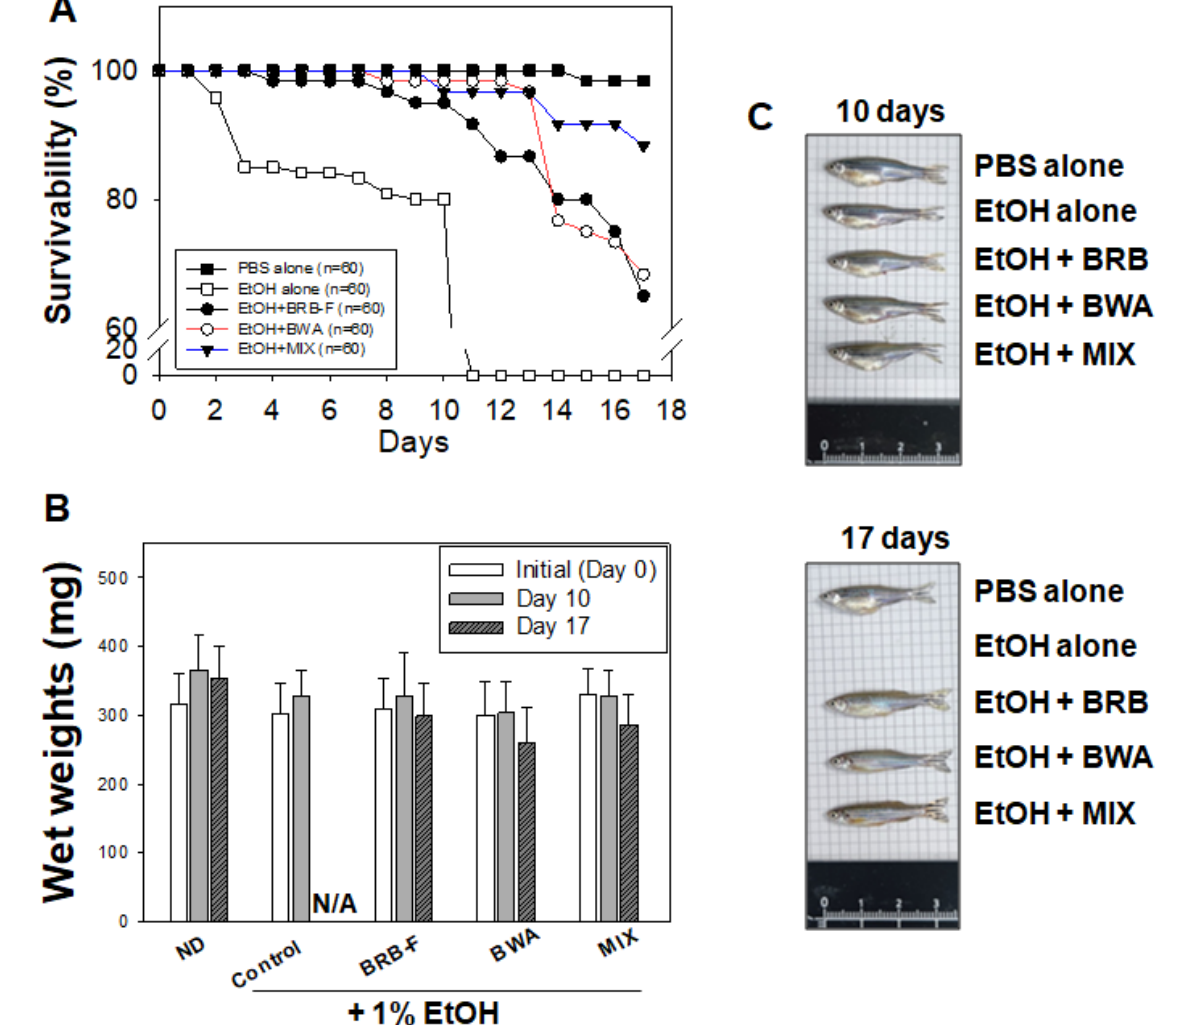
Figure 2. Effect of BRB-F, BWA, and MIX in alcohol liver injury zebrafish for 17 days on ( A ) survival and ( B ) body weights; PBS, normal diet, n = 20; EtOH, zebrafish exposed to 1% ethanol, n = 20; BRB-F, EtOH fed 10% black rice bran, n = 20; BWA, EtOH fed 10% beeswax alcohol, n = 20; MIX, EtOH fed a mixture of BWA and BRB-F (1:6, w / w ), n = 20. Photos of zebrafish body at 10 days and 17 days are shown ( C ).